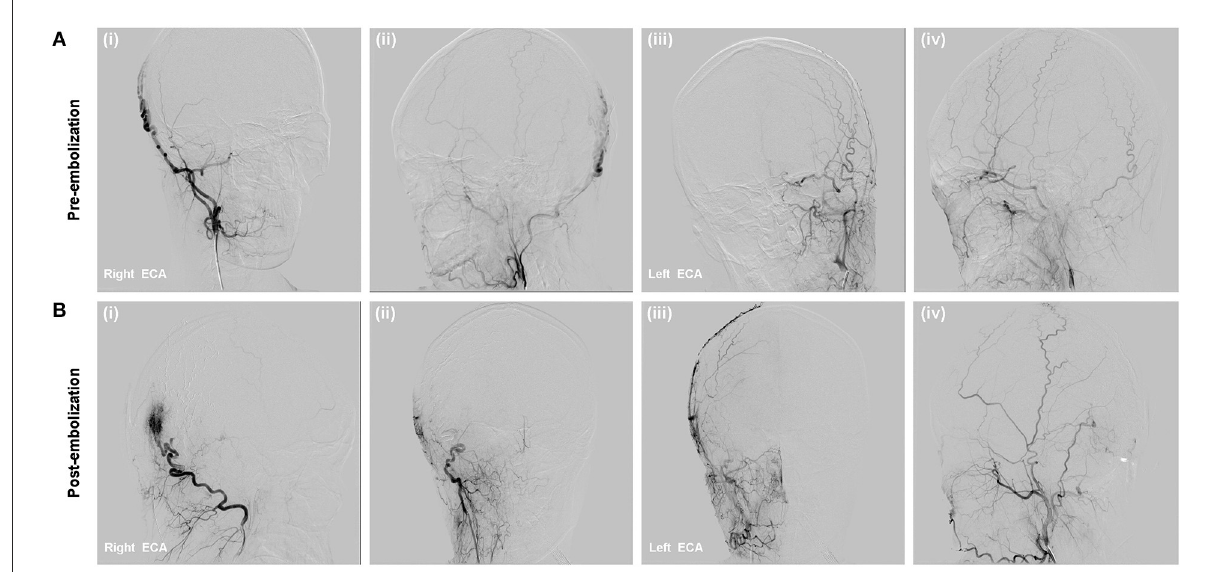
FIGURE4 (A) DSA showed right occipital high flow scalp AVM fed from the right OA branches and drained to the external jugular vein; (B) Onyx-18 was injected via direct percutaneous puncture approach (i,ii); Immediate complete occlusion of the scalp AVM post-embolization